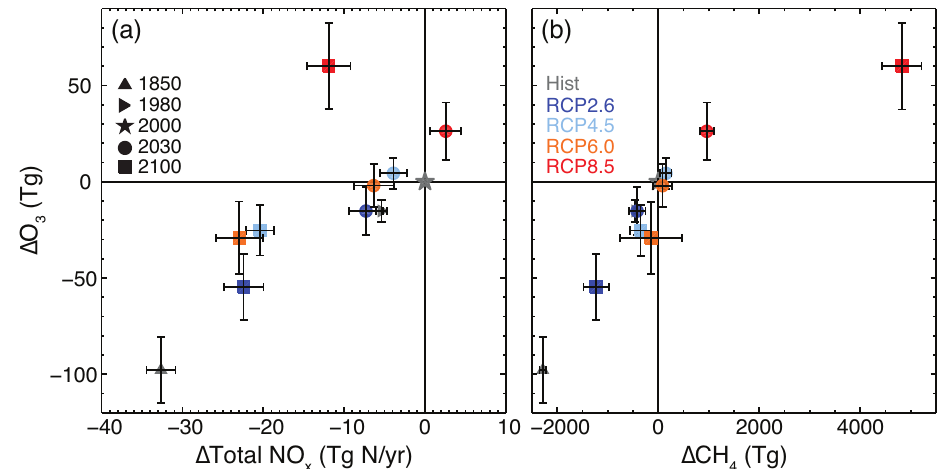
Fig. 13. ACCMIP ensemble mean change in the tropospheric ozone burden compared to the Hist 2000 simulation as a function of (a) changes in total NO x emissions and (b) changes in the tropospheric methane burden. Error bars indicate ± 1 std. dev. of the changes in ozone, NO x emissions and methane burdens, calculated from the spread of the models. Different colours represent the different scenarios, whereas different symbols represent the different time